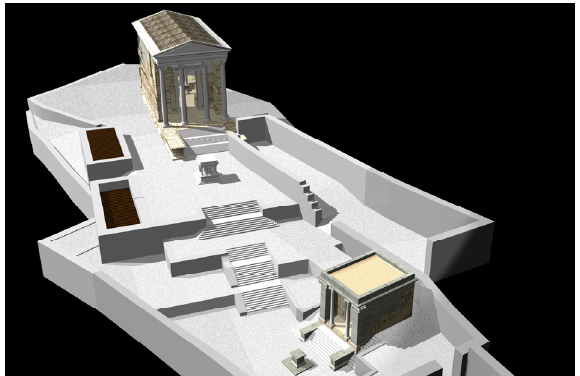
Figure 15. The architectural 3D model of the 2 nd sanctuary of Hosn-Niha . © J. Yasmine;